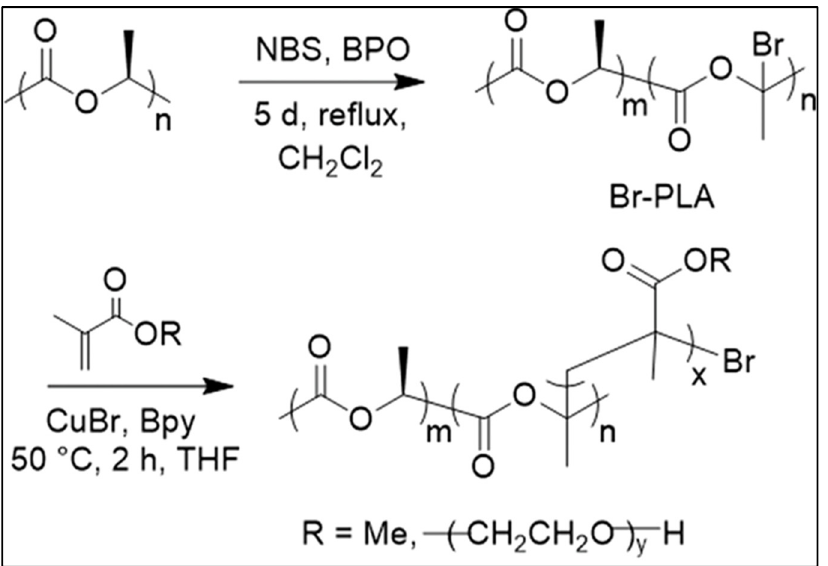
Figure 17. Formation of PLA- g -PMMA and PLA- g -POEGMA by ATRP (from Kalelkar et al. [92], copyright American Chemical Society, reproduced with permission). copyright American Chemical Society, reproduced with